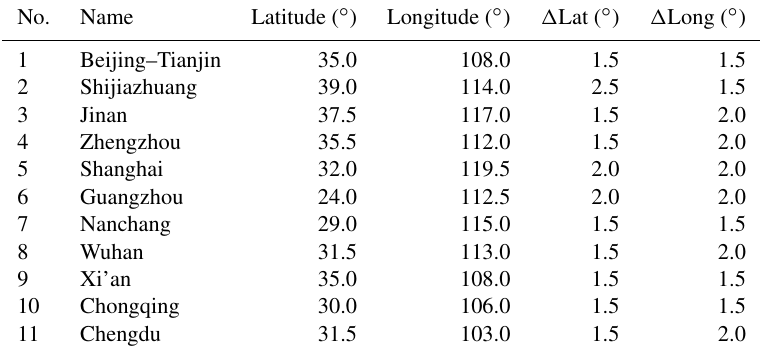
Table 1. Focus regions of the current study. The locations corresponding to the numbers in the first column are shown on the map in Fig. 1. Coordinates in columns 3 and 4 are for the upper left corner of each region; the size around the corner of each region is indicated in columns 5 and 6. Regions are indicated with the name of the central city. No. Name Latitude ( ◦ ) Longitude ( ◦ ) (cid:49) Lat ( ◦ ) (cid:49) Long ( ◦